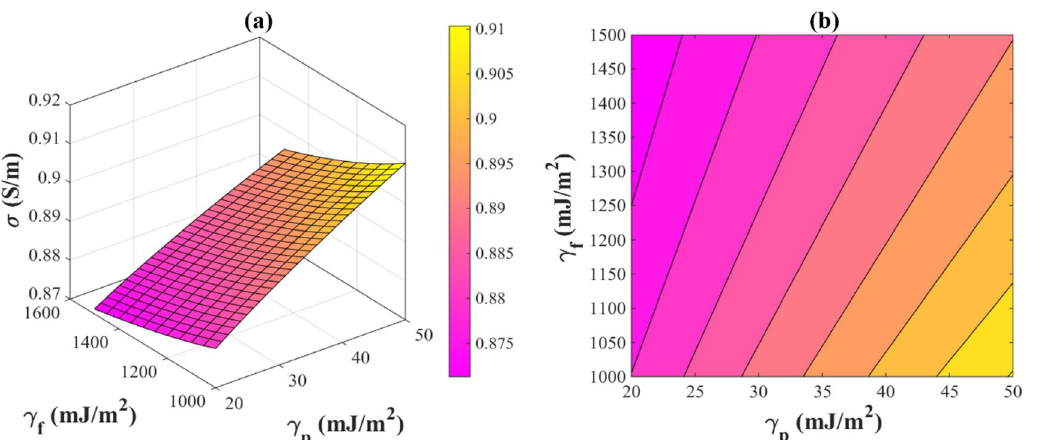
Figure 1. The effects of “ γ f and “ γ p ” on the electrical conductivity of a PNC by ( a ) 3D and ( b ) contour plots.